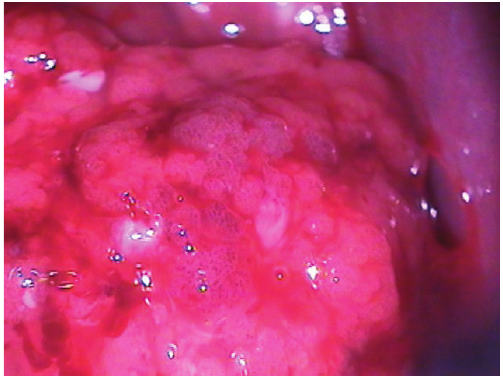
Figure 1: Colposcopy: cerebroid lesion with dense acetowhite epithelium, mosaic, and atypical vascularization.